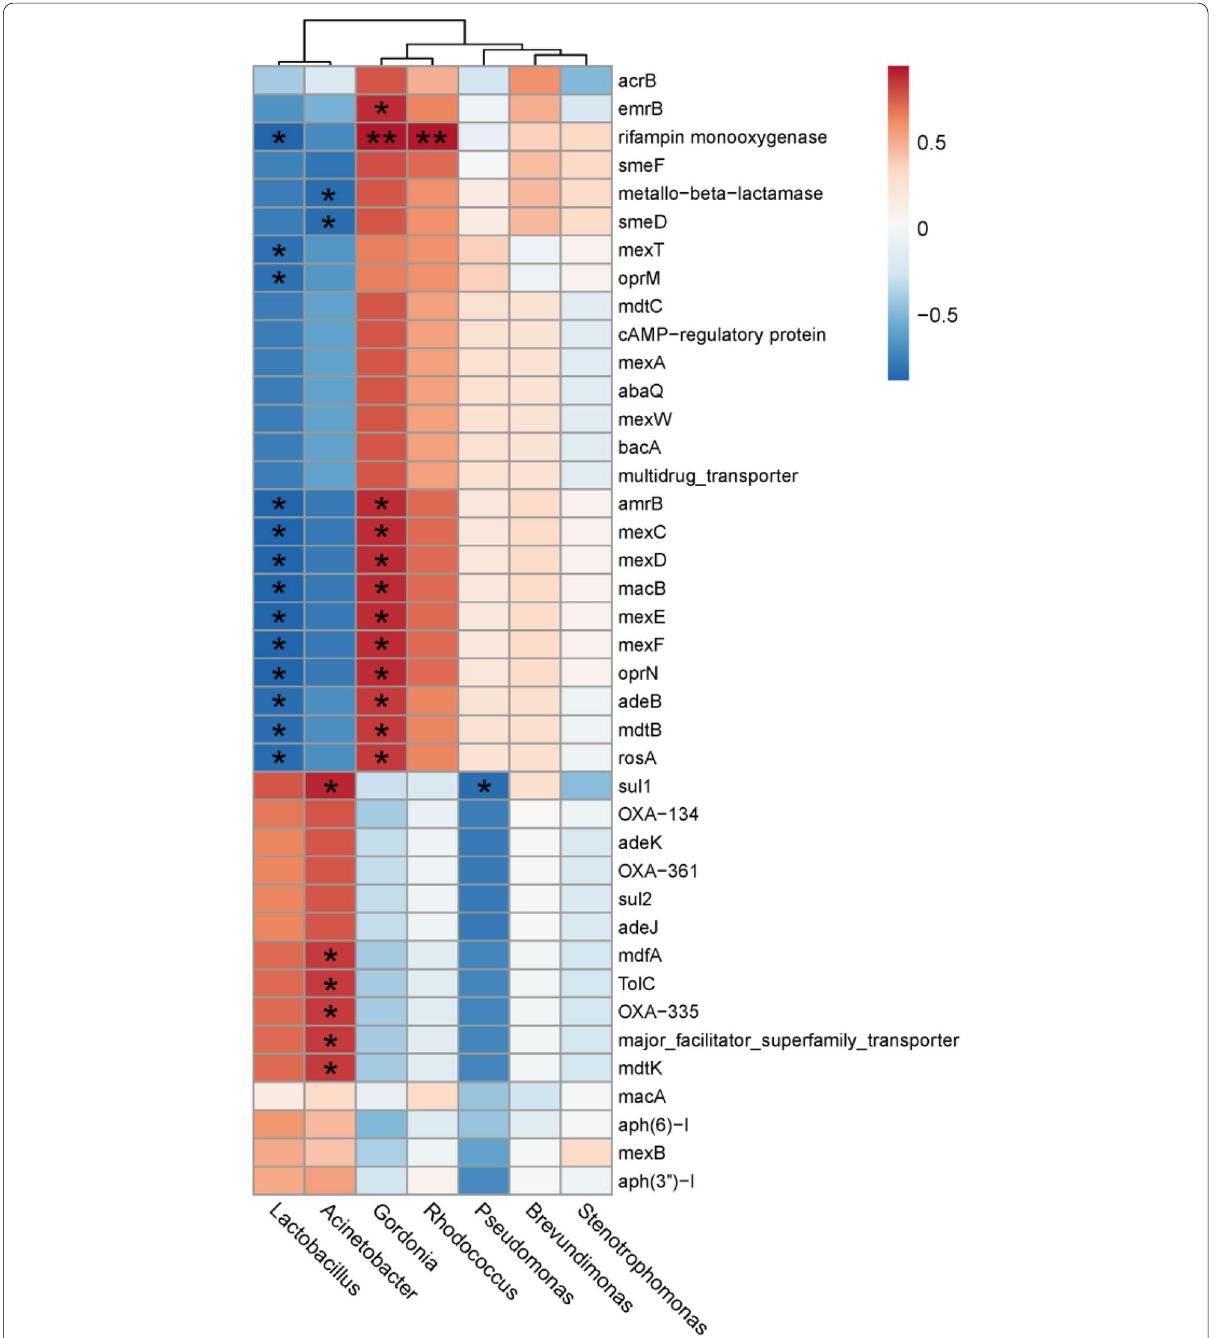
Fig. 5 Spearman correlations between ARG subtypes and the top 7 bacteria at the genus level. Red and blue indicate positive and negative correlations, respectively. Asterisks mean strong significant correlation (** P < 0.01) and significant correlation (* P < 0.05). The absolute values of the correlation coefficients are all greater than 0.8 in the places marked with